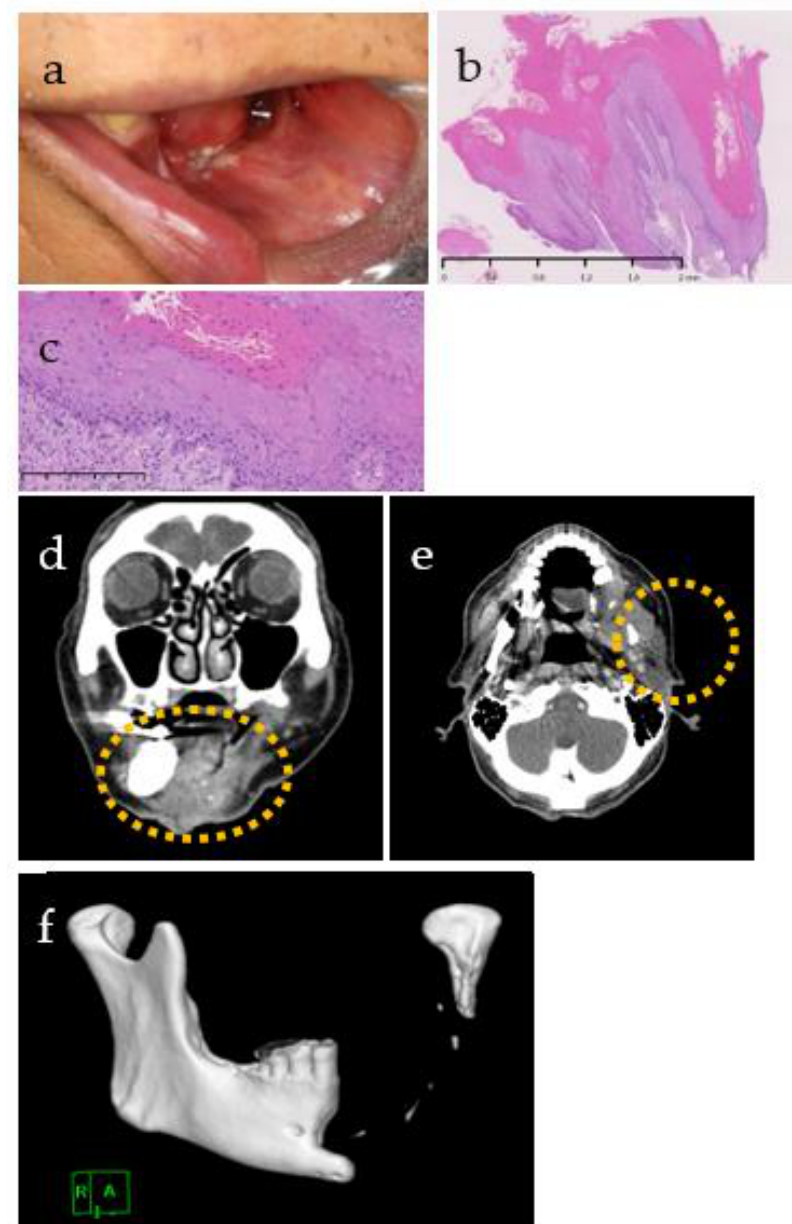
Figure 7. ( a ) Intraoral photograph, ( b , c ) photomicrograph and computed tomography, ( d – f ) before and after the diagnosis of CC. ( a ) The wound re-opened, and white keratin appeared. Papillary hyperplasia of baking soda ( b ) and mild atypia in the epithelial cells ( c ) were observed, leading to a diagnosis of carcinoma cuniculatum. Stain, hematoxylin and eosin (H&E); magnification, original × 20 ( b ) and × 200 ( c ). ( d – f ) Wide extension beyond the mandible of an irregular soft tissue mass (yellow dotted circle) with a contrasting effect was observed, and obvious osteolytic changes in the stump of the remaining left mandibular condyle were also observed.